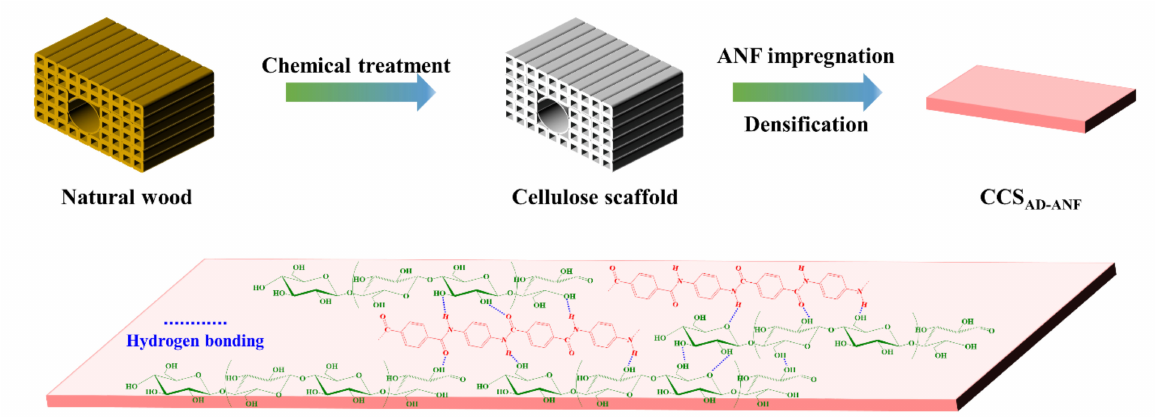
Figure 1. The preparation process of a high-performance cellulosic bulk material. In the microstructure of wood, the lignin plays a role of adhesive, which sticks cel- lulose and hemicellulose together. However, its existence decreased the accessibility of cellulose, restricting possible functionalization. So, the natural basswood was subjected to sodium chlorite (NaClO 2 ) and sodium hydroxide (NaOH) treatment to remove lignin and hemicellulose. Results from the delignification process showed that the delignified wood contained 80.2% cellulose, 13.5% hemicellulose and 1.7% lignin, demonstrating 38.8% hemicellulose and 93.1% lignin removal (Figure 2a). In addition, samples of each stage under preparation showed different physical performance. Compared to NW, the CS AD exhibited slightly increased density (0.5 vs. 0.4 g cm − 3 for NW) and smaller porosity (66.7 vs. 73.3% for NW) due to air shrinkage (Figure 2b). The result of FTIR spectra of NW and CS also echoed the component analysis as shown in Figure 2c,d. For NW, the presence of 1584 cm − 1 and 1502 cm − 1 (C=C stretching vibration of the aromatic rings) represents the typical structure of lignin, while the band locating in 1237 cm − 1 belongs to the C-O stretching of the aromatic rings. In addition, the peak at 1729 cm − 1 is ascribed to unconjugated carbonyl C=O in hemicellulose. After NaClO 2 and NaOH treatment, there are not these characteristic peaks for lignin and hemicellulose in CS